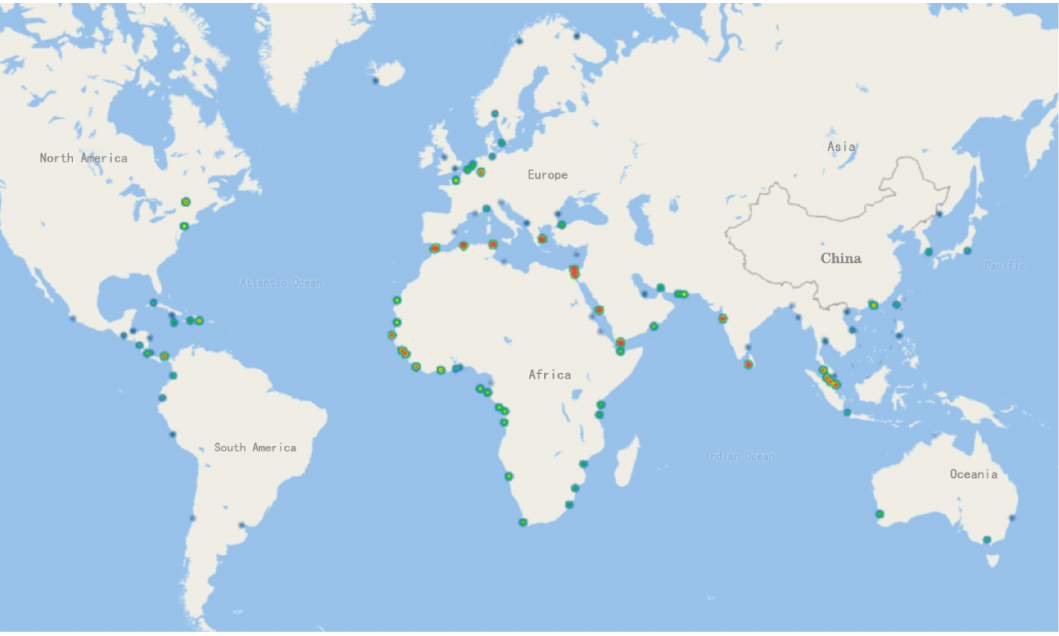
Figure 1: The thermodynamic diagram about the number of ports crossed by the shortest path.